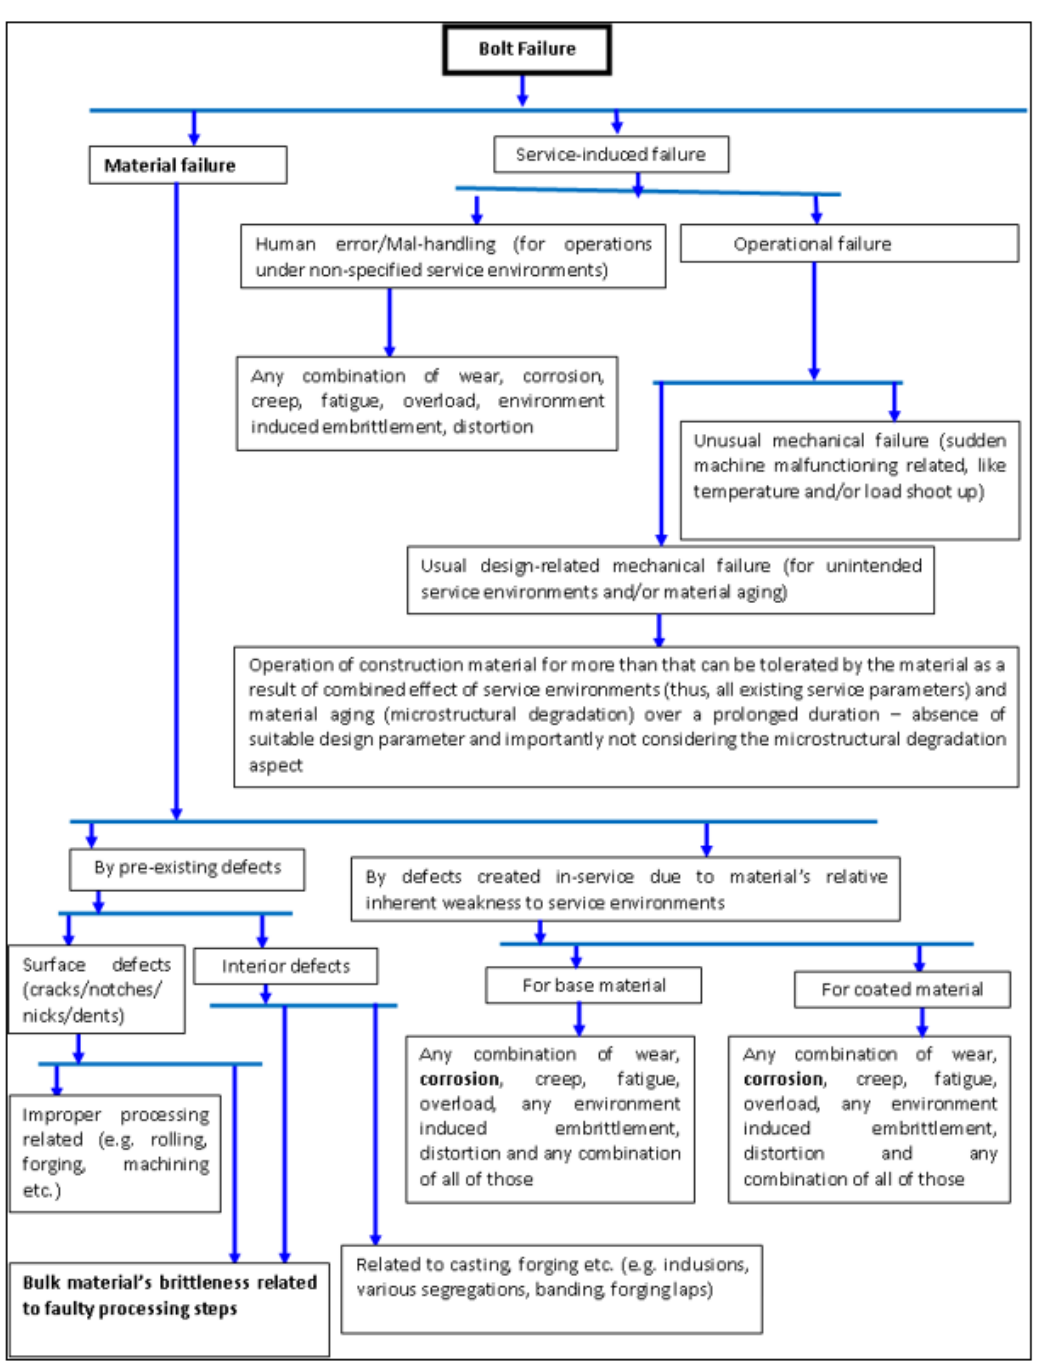
Figure 11: Proposed schematic sequential representation of the probable causes of failure of the bolt facilitating to arrive at conclusion in present failure analysis case (bold captions indicate the concluded most probable